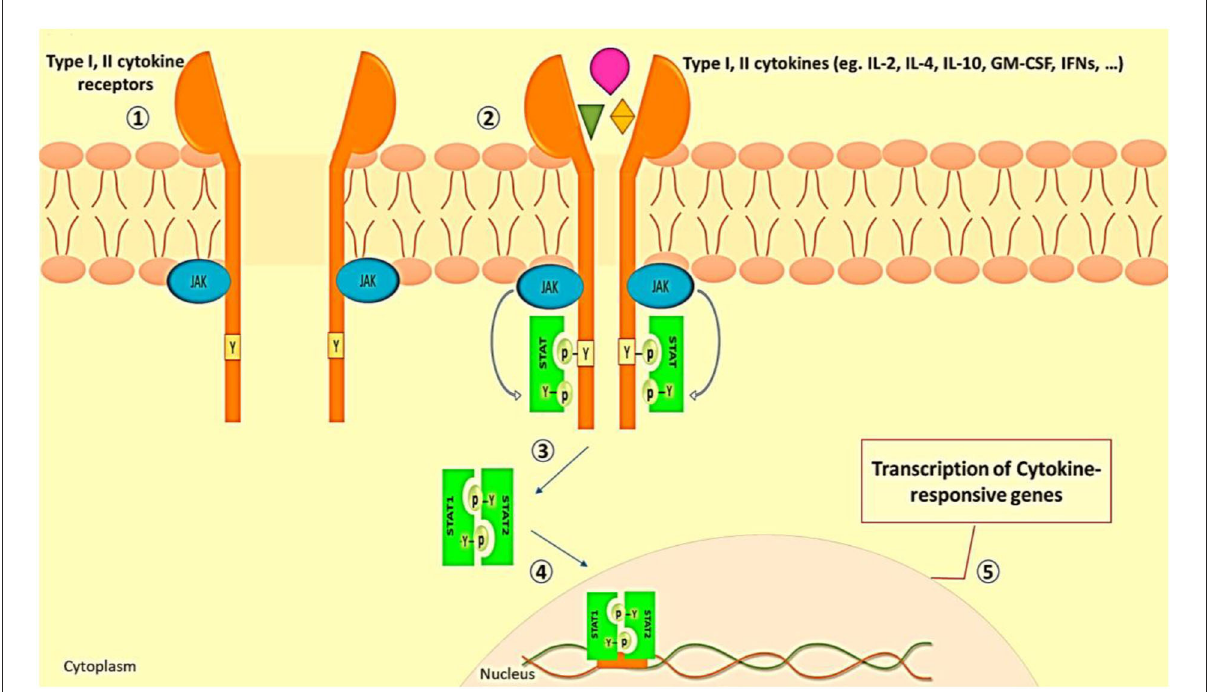
FIGURE2 JAK/STAT signaling induction by type I and II cytokines. (1) In the resting state, the subunits of type I and II cytokine receptors are at a short distance from each other. (2) The engagement of ligand with receptors leads to receptor dimerization and JAK activation. (3) The activated JAKs phosphorylate the tyrosine residue of the receptor which recruits various members of STAT proteins. (4) Phosphorylated and activated STATs make themselves dimmer. (4) STATs complex translocates to the cell nucleus. (5) STATs bind to the promoter and lead to the transcription of cytokine-responsive genes